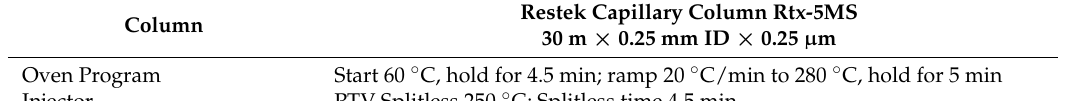
Table 2. Operating parameters for gas chromatography-mass spectrometry (GC/MS) analysis. Restek Capillary Column Column